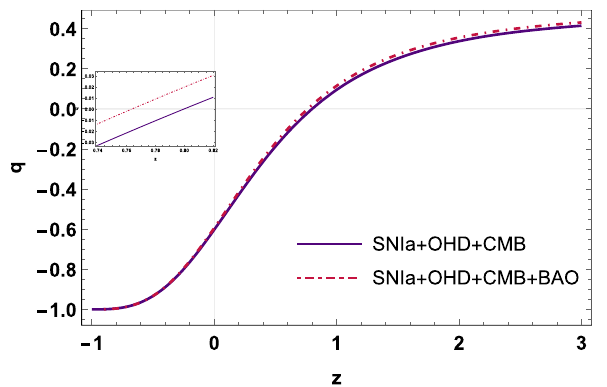
Fig. 4 The evolution of deceleration parameter with redshift for the best estimated values of the model parameters using the fourth and sixth datasets. The inset figure clearly distinguishes the continuous and dot-dashed lines